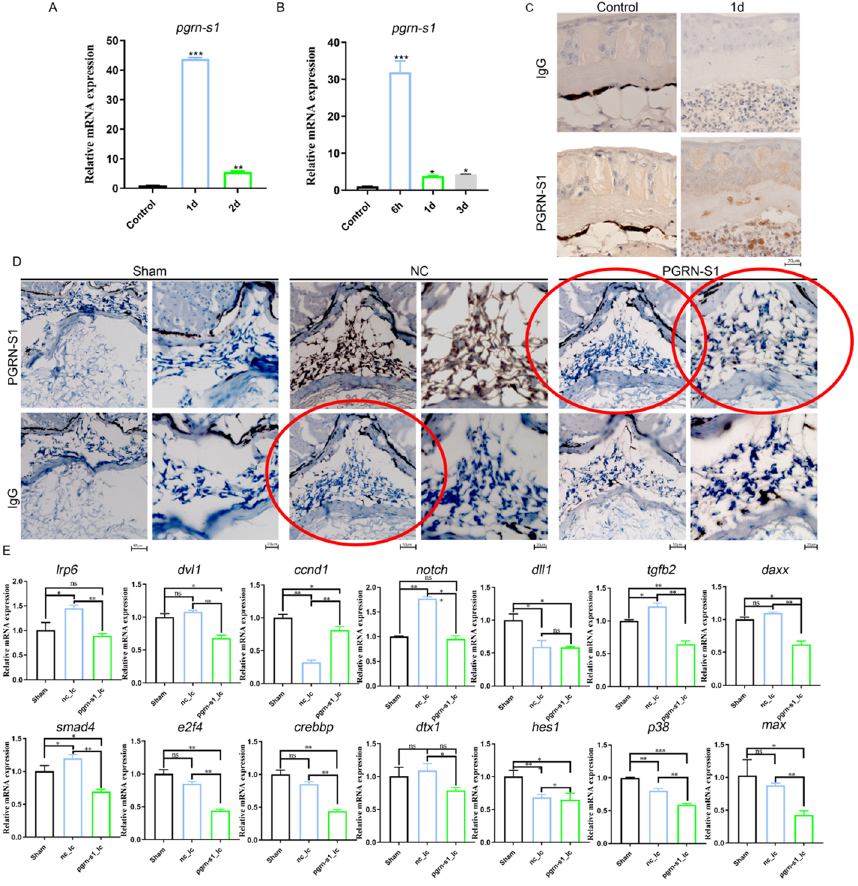
Fig. 5 Expression of Lr-pgrn-s1 after lamprey skin and spinal cord injury. A Expression of Lr-pgrn-s1 in lamprey skin lesions 1d and 2d. B Expression of Lr-pgrn-s1 in lamprey spinal cord injury at 6 h, 1d and 3d by qRT-PCR. C Detection of tissue localization of Lr- magnifica- PGRN-S1 in skin injury 1d by immunohistochemistry. Take pictures at 40 × tion. D Immunohistochemistry of Lr-pgrn-s1 was knocked down 6 h after lamprey spinal cord injury. Results under 20 and 40 microscopy in Sham, NC (normal control) and × × Lr-PGRN-S1 groups. E The qRT-PCR analysis of genes in MAPK, Notch, Wnt and TGF-β signaling pathways. The statistical differences between experimental groups were detected by the Student’s t test. All data were presented as the means SDs based on three inde- ± pendent samples with three replicates per sample. ns non-significant, * P < 0.05, ** P < 0.001, *** P <